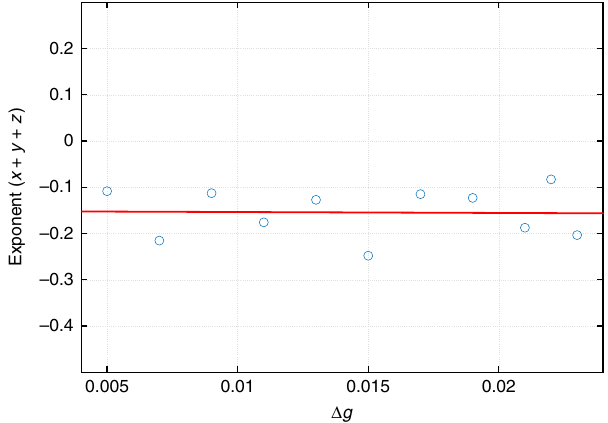
Fig. 9 2nd-order reaction case. a The root-mean-square deviation of μ 1 from a reference solution as a function of the number of grid points. The number of grid points of the reference solution is 2800. R p = 150. b The root-mean-square deviation of μ 1 from a reference solution as a function of the patching radius R p . In that reference solution, R p = 150. The number of grid points is fi xed at 26 per unit length. The rest of the parameter values are the same as in Fig. 7